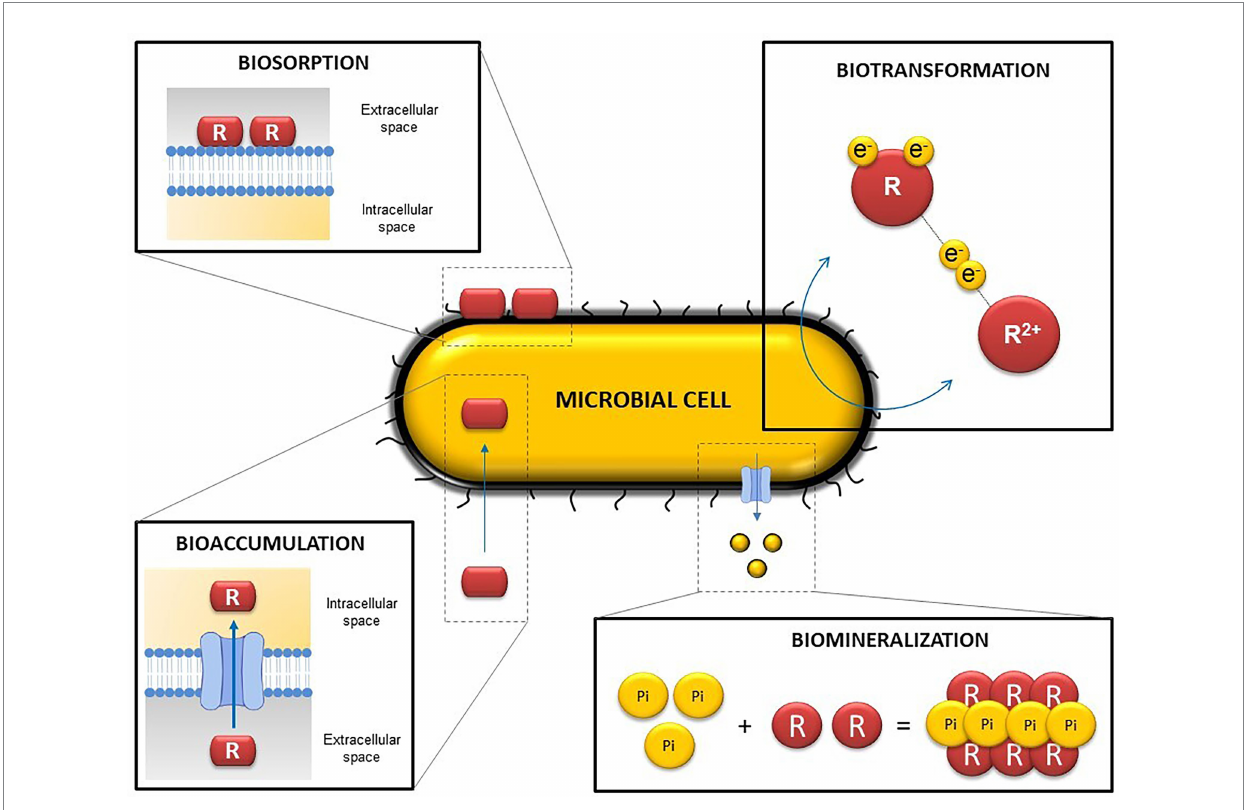
FIGURE 4 Representative diagram illustrating the main microbial mechanisms involved in radionuclide and heavy metal mobilization. R,